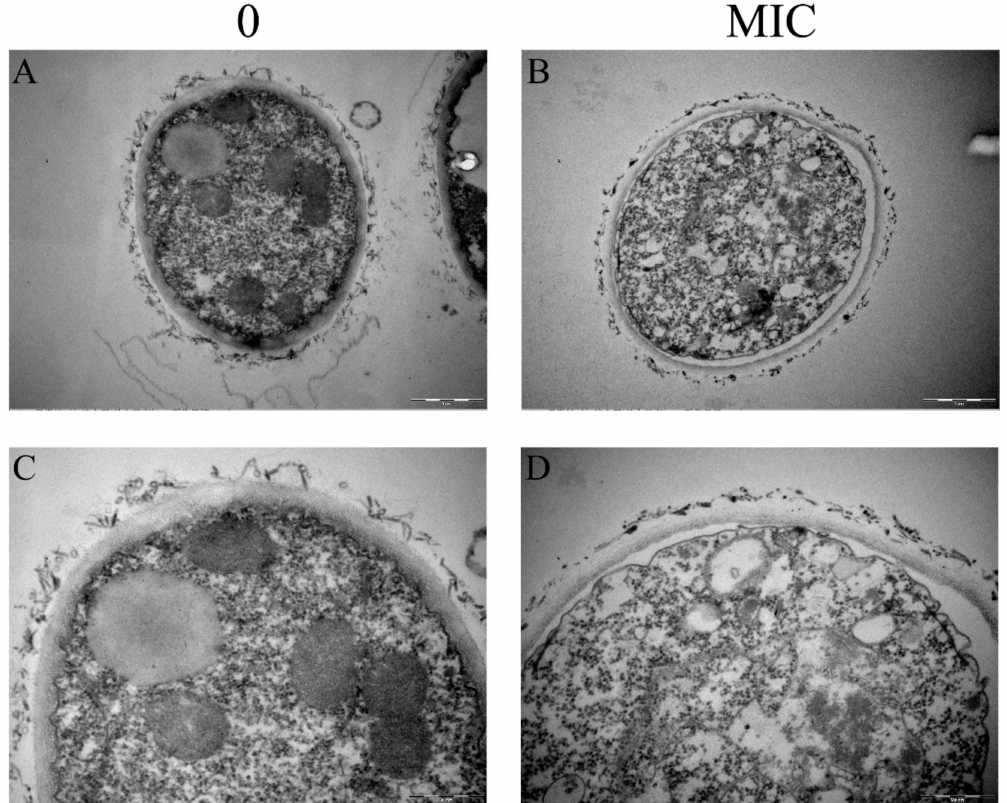
Figure 1. TEM characterization of A. flavus treated with paeonol at 0 ( A , C ) and MIC ( B , D ). Scale bar: 1 µ m.